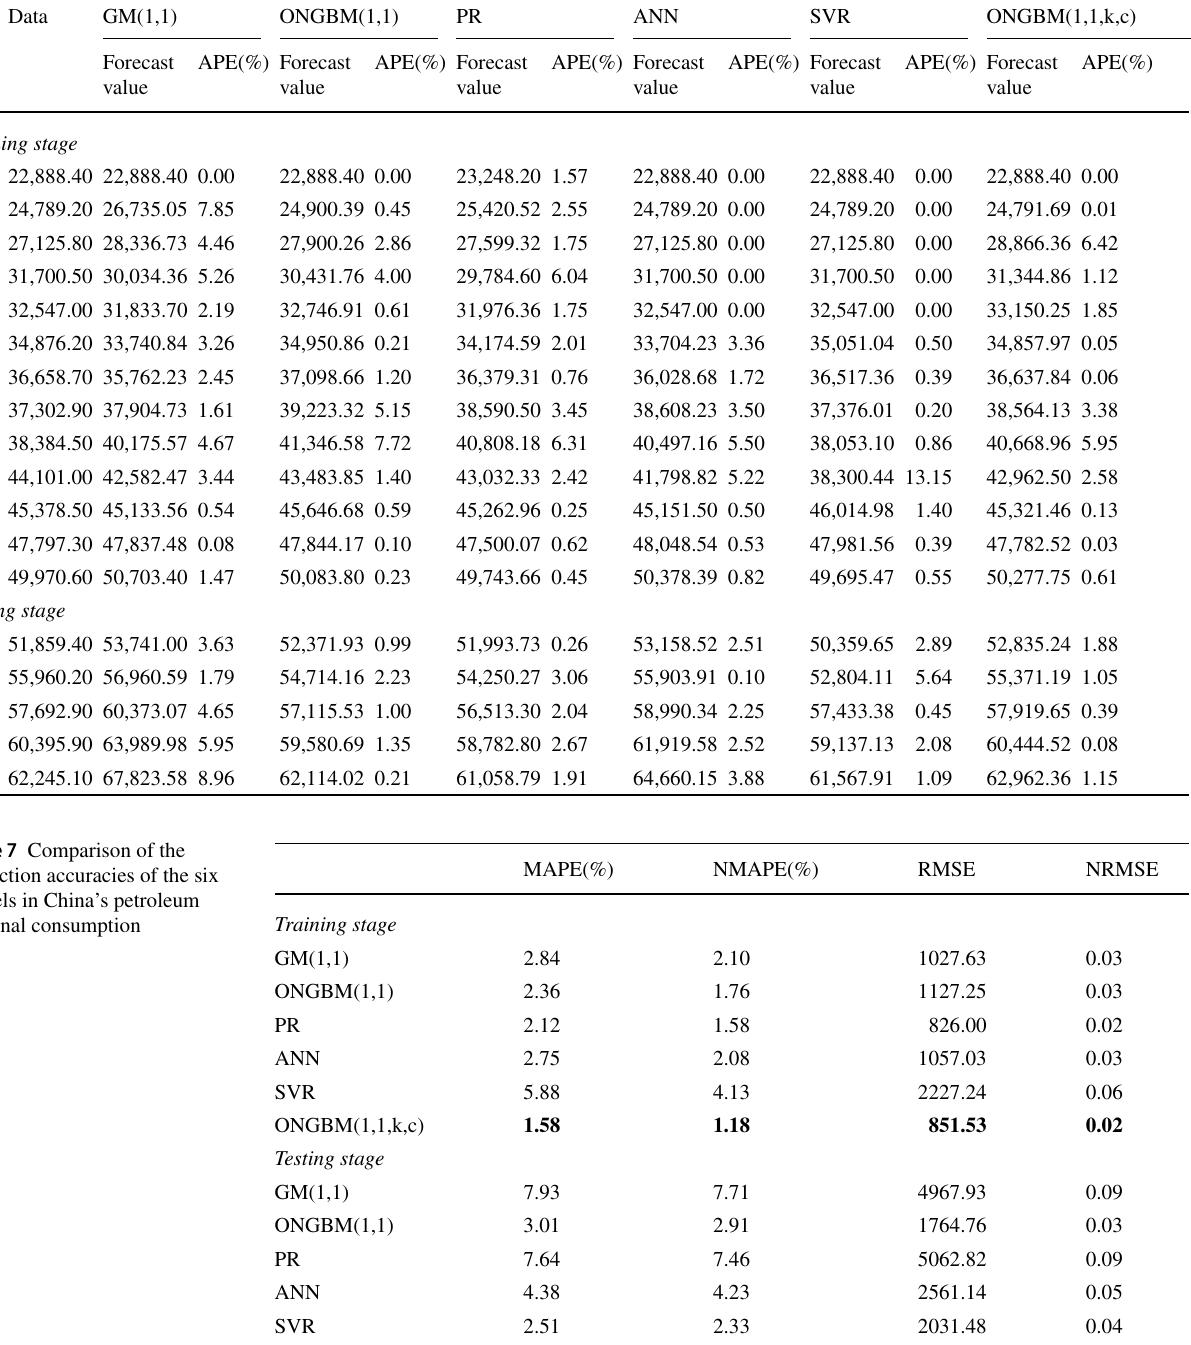
Table 6 Simulated and forecasted values of China’s petroleum terminal consumption using different models Year Data